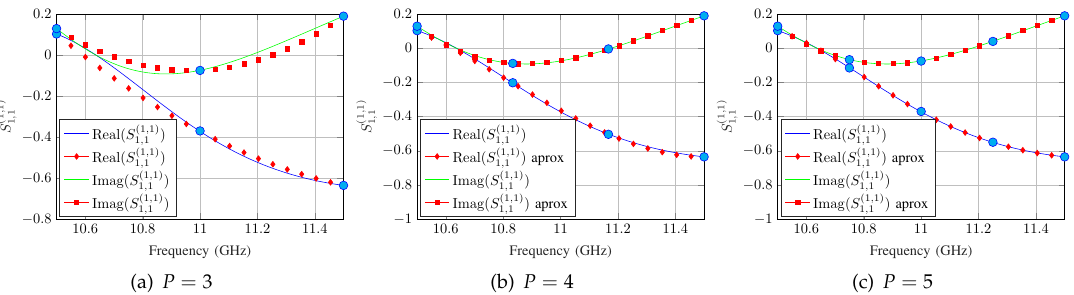
( 1,1 ) of the first dielectric post of the 1,1